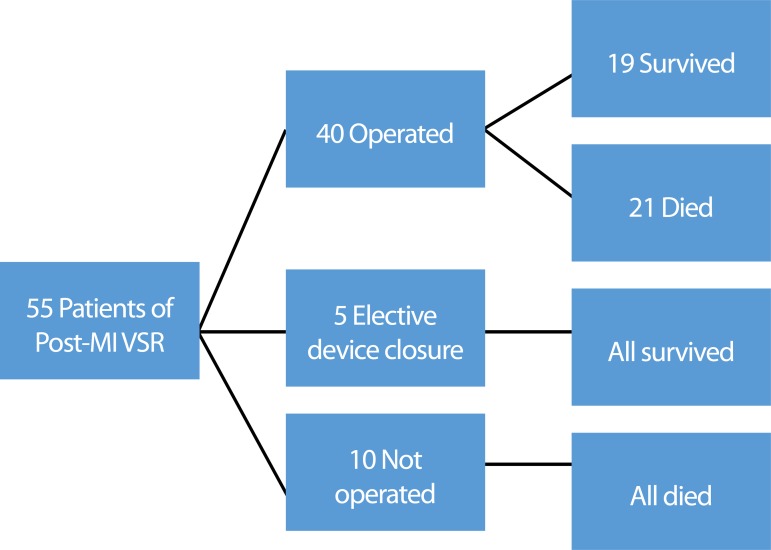
Flow chart showing different interventions and outcomes of
patients.